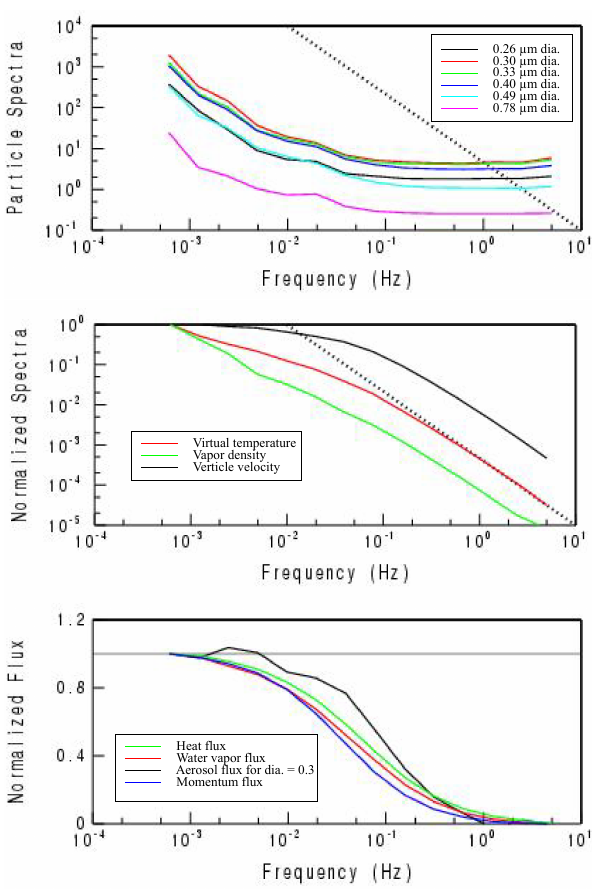
Fig. 2. Spectra and co-spectra for the indicated variables from 70 daytime 30min periods (for the 25% of periods with the highest aerosol concentrations during BEARPEX). The variances and co- variances (and their normalized values) that are presented on the Y- axes were calculated using the multiresolution decomposition meth- ods described by Howell and Mahrt (1997) and Vickers and Mahrt